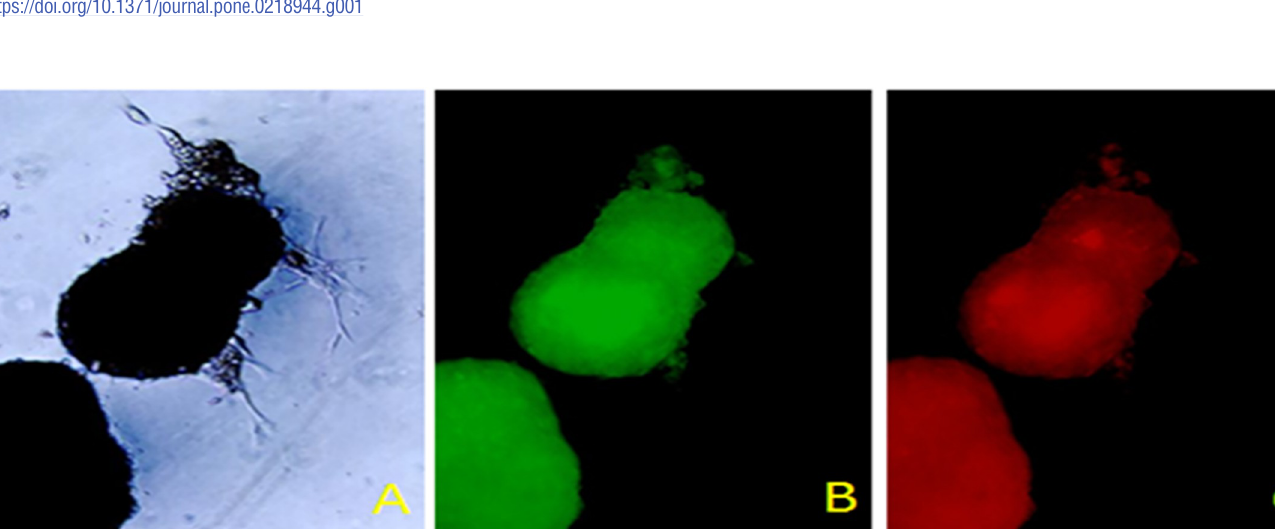
PLOS ONE | https://doi.org/10.1371/journal.pone.0218944 July 17,